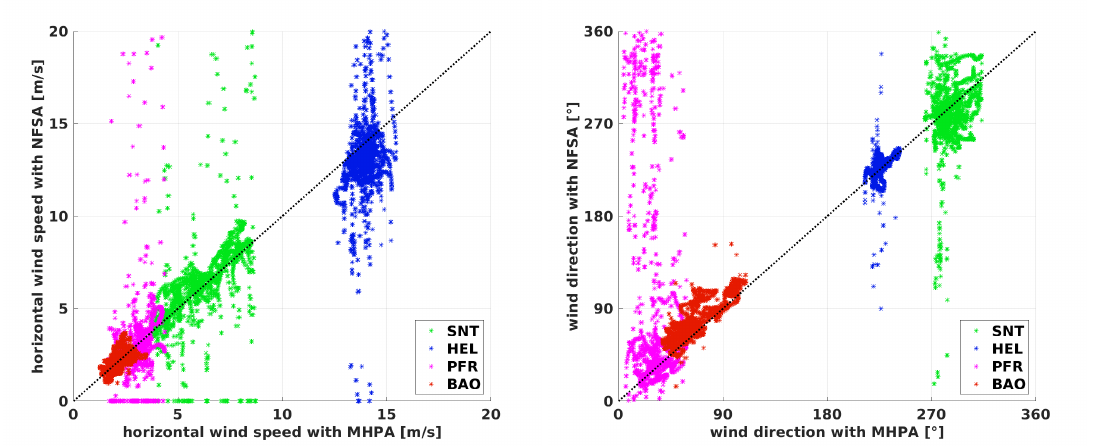
Figure 12. Comparison of the horizontal wind speed ( left ) and the wind direction ( right ) on a window of 1 min for the flights at the Boulder Atmospheric Observatory (BAO), Schnittlingen (SNT), Helgoland (HEL), and Pforzheim (PFR). The black dashed line shows the bisecting line where the multi-hole-probe algorithm (MHPA) equals the no-flow-sensor algorithm (NFSA). The data is calculated on a window with M = 60 s. The results from the MHPA are plotted against the results from the NFSA